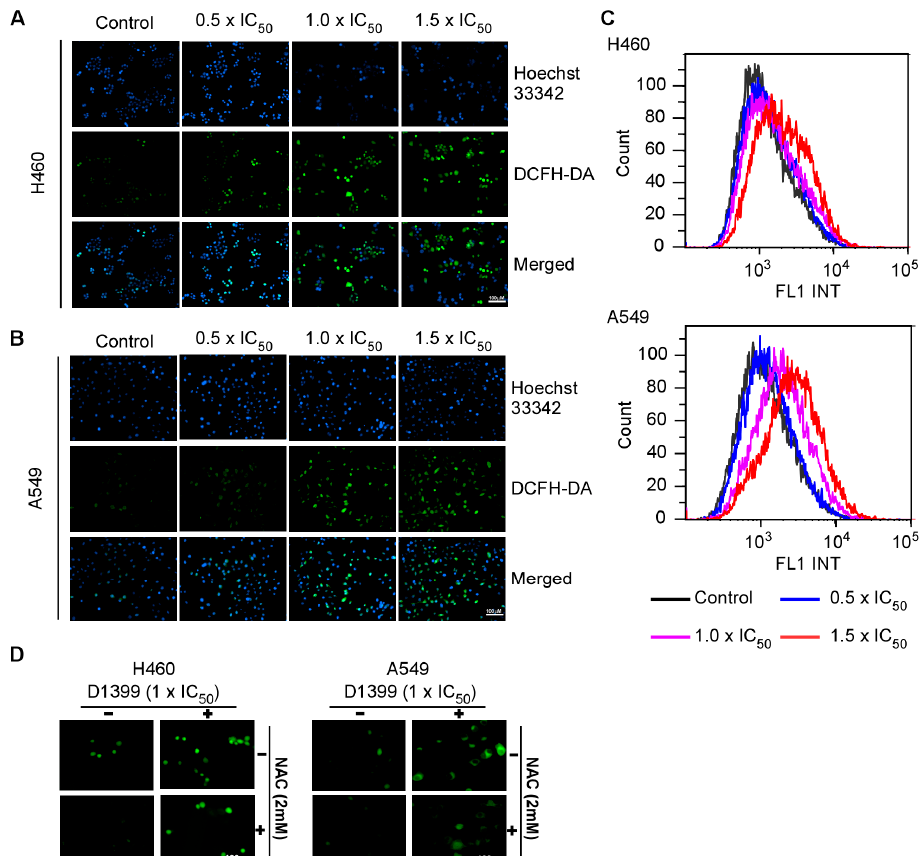
Figure 4. D1399-induced ROS generation in H460 and A549 cells. The cells were treated with D1399 at concentrations of 0.5 × IC 50 , 1.0 × IC 50 , and 1.5 × IC 50 for 4 h, and the living cells and ROS were labeled with Hocchst33342 and DCFH-DA, respectively. ( A , B ) Fluorescence micrograph of H460 ( A ) and A549 ( B ) cells labeled by Hocchst33342 and DCFH-DA; ( C ) The ROS accumulation in H460 and A549 was observed by flow cytometry; ( D ) Fluorescence micrograph of H460 and A549 cells labeled by DCFH-DA. The cells were either treated with D1399 at concentrations of 1.0 × IC 50 for 4 h or pre-treated with 2 mM NAC for 1 h before D1399 treatment. The images presented here are captured from one experiment, and are representative of at least three independent experiments.